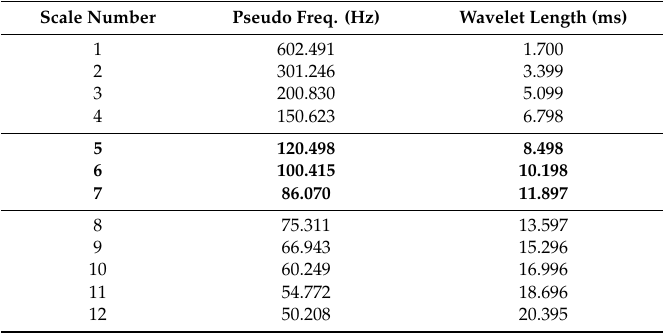
Table 1. Scale number, pseudo-frequency approximation, and wavelength of the rbio2.8 mother wavelet over the scale range of